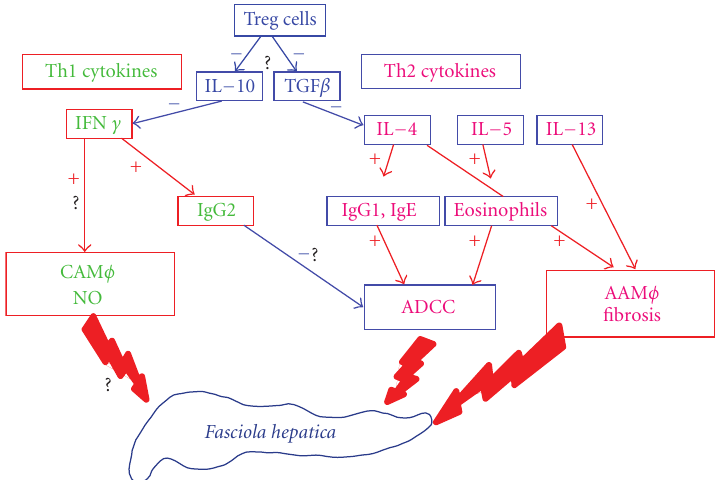
Figure 1: Immune mechanisms and regulation induced against Fasciola hepatica . Two main immune mechanisms are directed against F. hepatica in the liver parenchyma: (i) during the early phase of infection, classically activated macrophages may induce nitric oxide production which is toxic for the fluke. This mechanism needs to be confirmed and may be upregulated by Th1-type cytokines and downregulated by IL-10 produced by T regulatory cells. (ii) During the chronic phase of infection, antibody-dependent cellular cytotoxicity (ADCC) allows the release of toxic mediators such as major basic protein, eosinophil cationic protein, and reactive nitrogen intermediates. This mechanism is upregulated by Th2-type cytokines. T regulatory cells (Treg cells) produce IL-10 TGF β which inhibit the production and function of Th1 cytokines. They downregulate any excessive Th2 response in the immunopathogenesis of fasciolosis. Finally, alternative activated macrophage (AAM φ ) produces molecules that are toxic to the fluke and participates in fibrosis and tissue